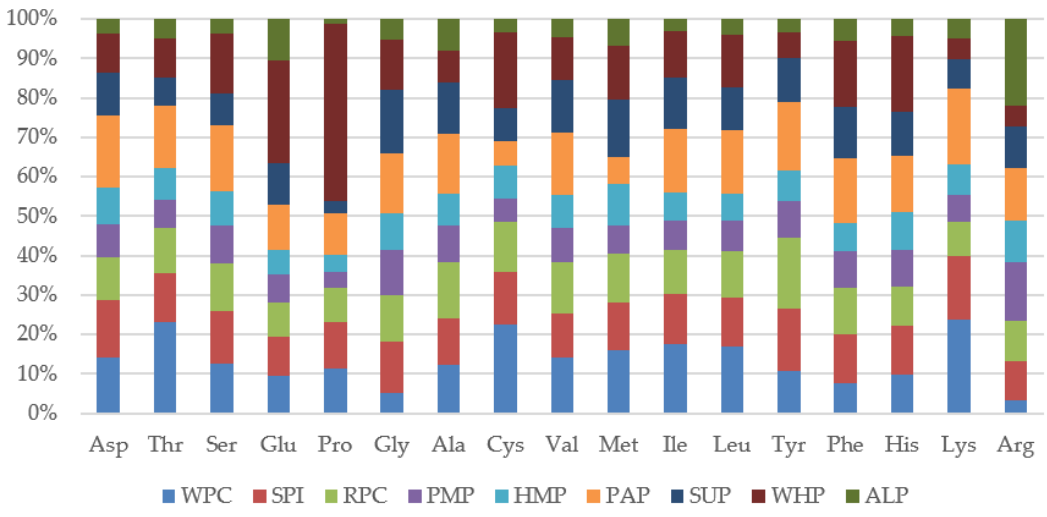
Figure 5. Percentage of individual amino acids in the high-protein bars.